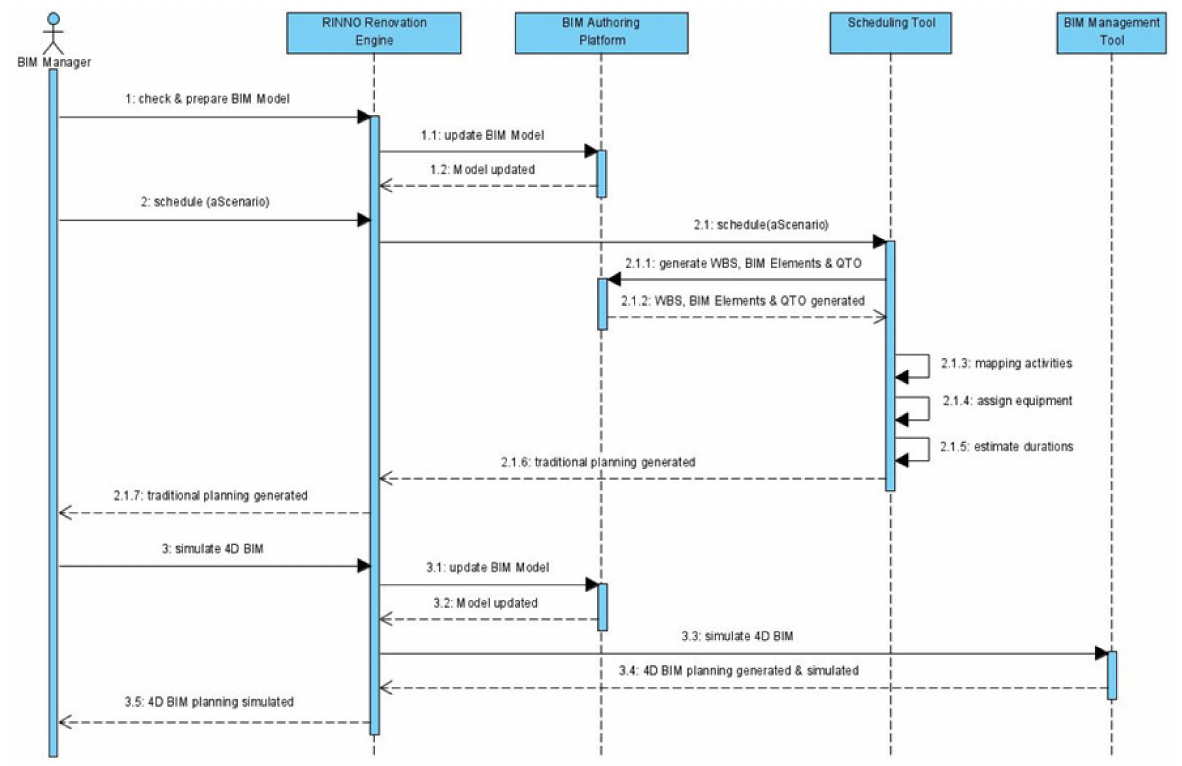
Figure 15. Automated 4D BIM planning and